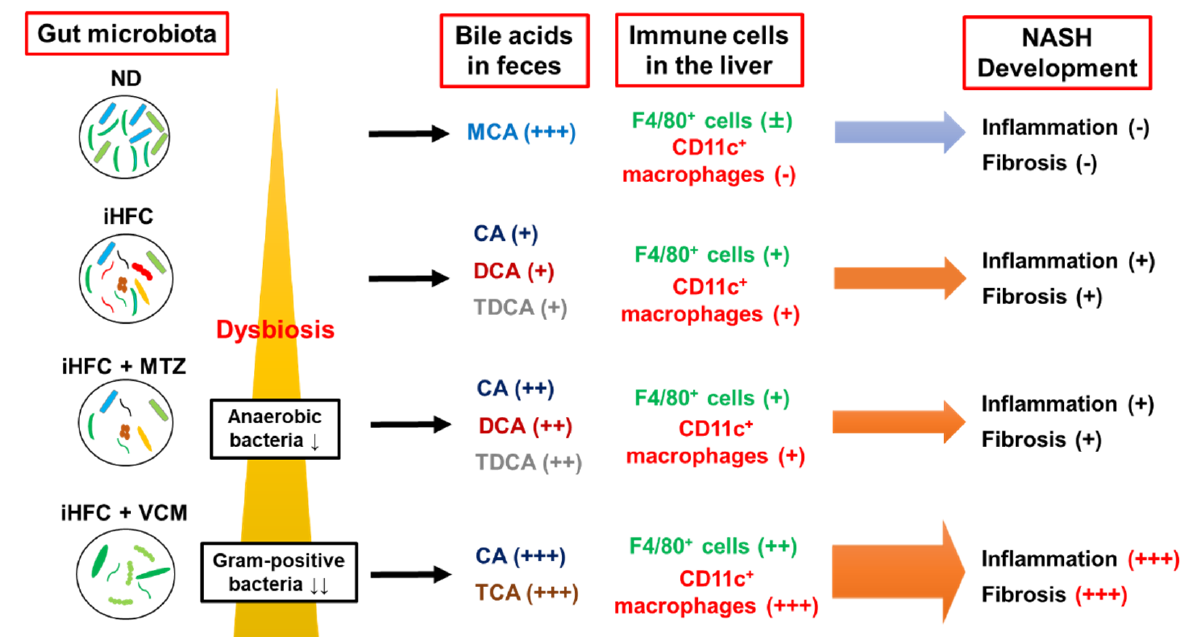
Figure 9. A summary of the effects of antibiotics treatment on BA metabolism, dynamics of immune cells, and development of inflammation and fibrosis in the iHFC diet-induced mouse NASH model.